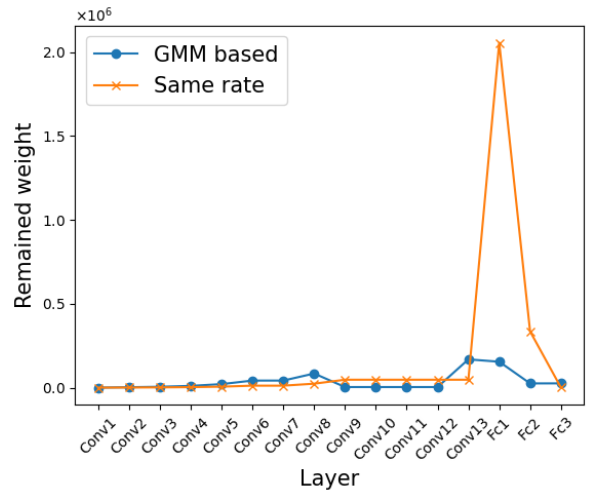
Figure 9. The graph of remaining weights of each layer. Difference between each layers weight is smaller when using GMM-based pruning than applying same rate. It means GMM-based pruning solves the bottleneck problem which can bring difficulty of training. In addition, it can reduce considerable redundancy, so it can compress the network significantly.